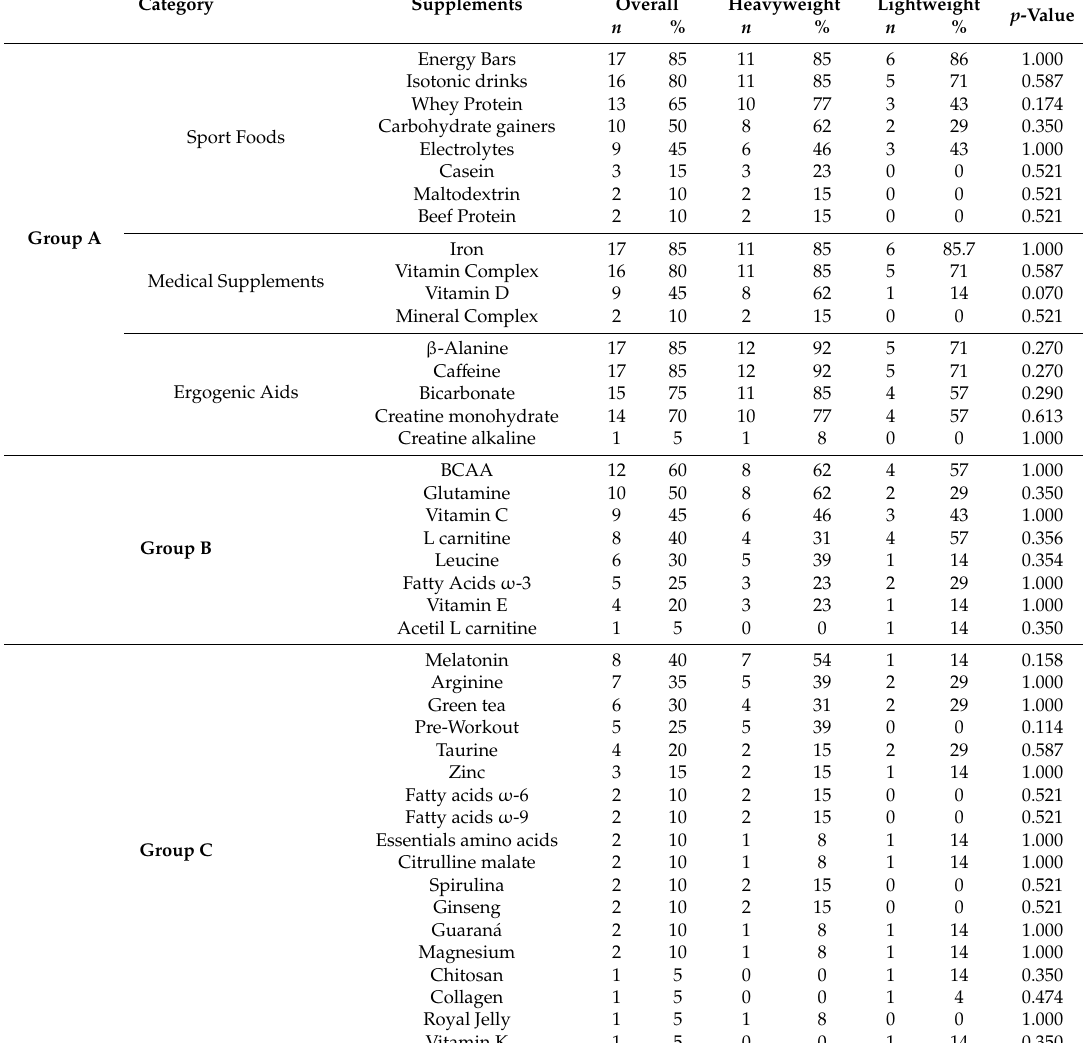
Table 3. SS consumption of heavyweight and lightweight rowers in the specific categories by the AIS